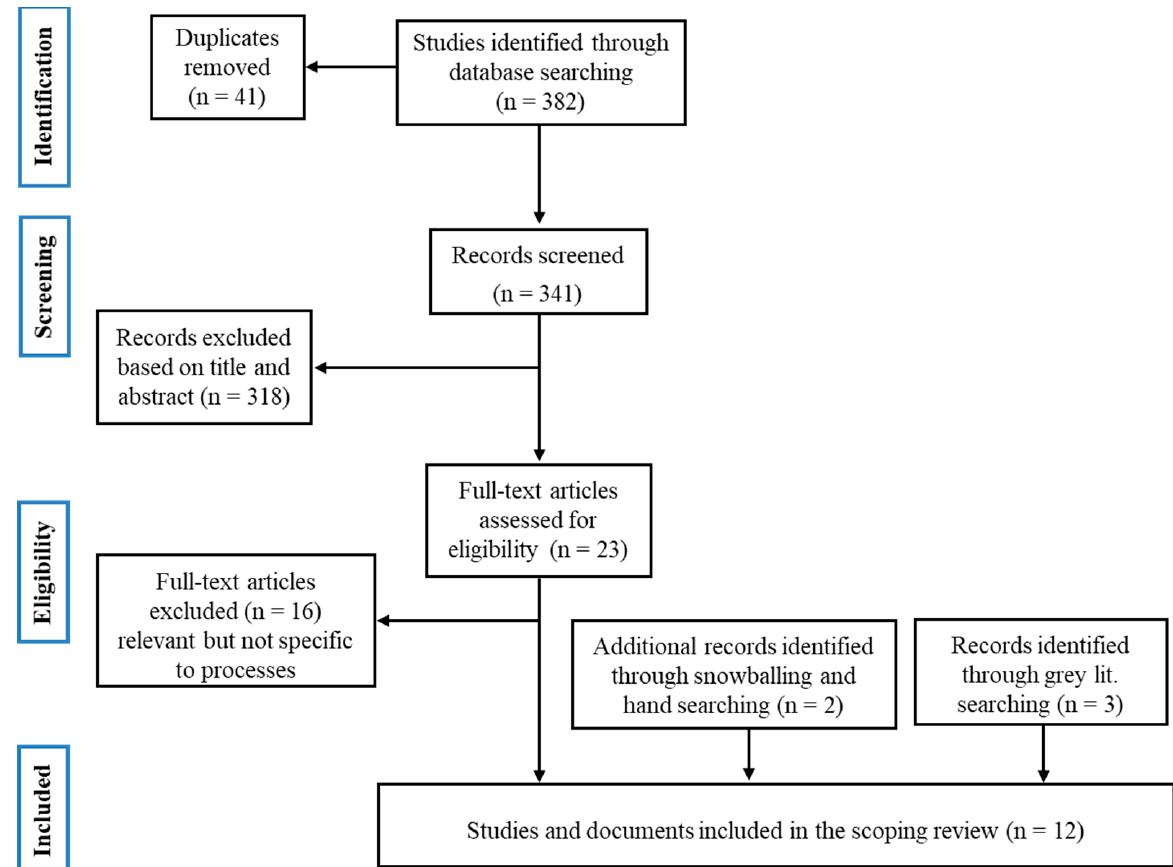
Figure 1. Preferred Reporting Items for Systematic Reviews and Meta-Analyses (PRISMA) flow diagram of included documents.